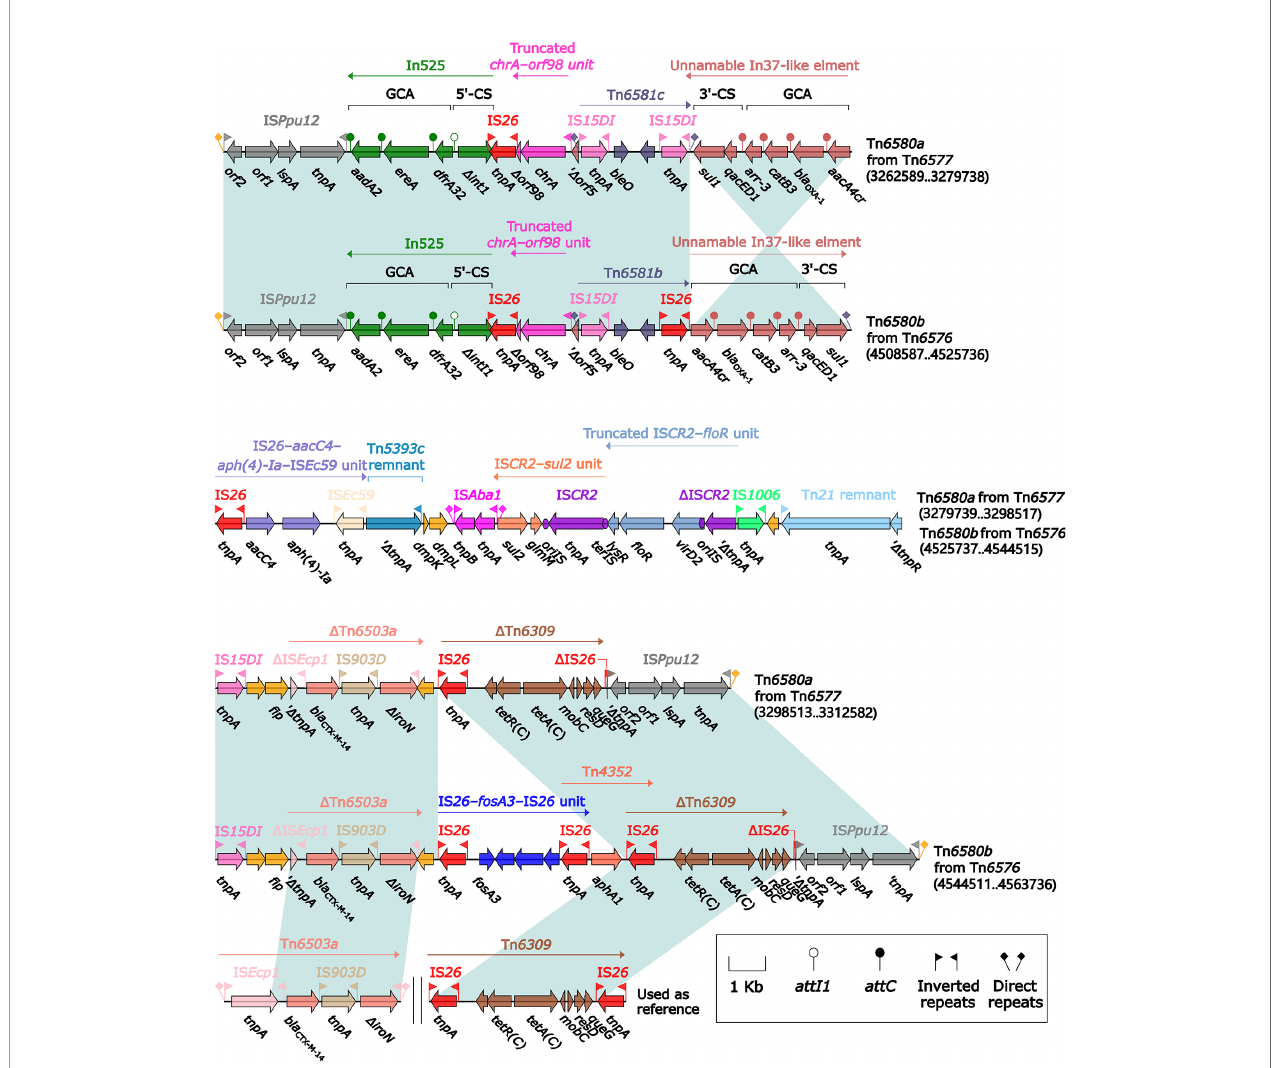
FIGURE 7 | Comparison of Tn 6580a from Tn 6577 and Tn 6580b from Tn 6576 , and related regions. Genes are denoted by arrows. Genes, mobile elements, and other features are colored based on their functional classi fi cation. Shading denotes regions of homology (nucleotide identity ≥ 95%). Numbers in brackets